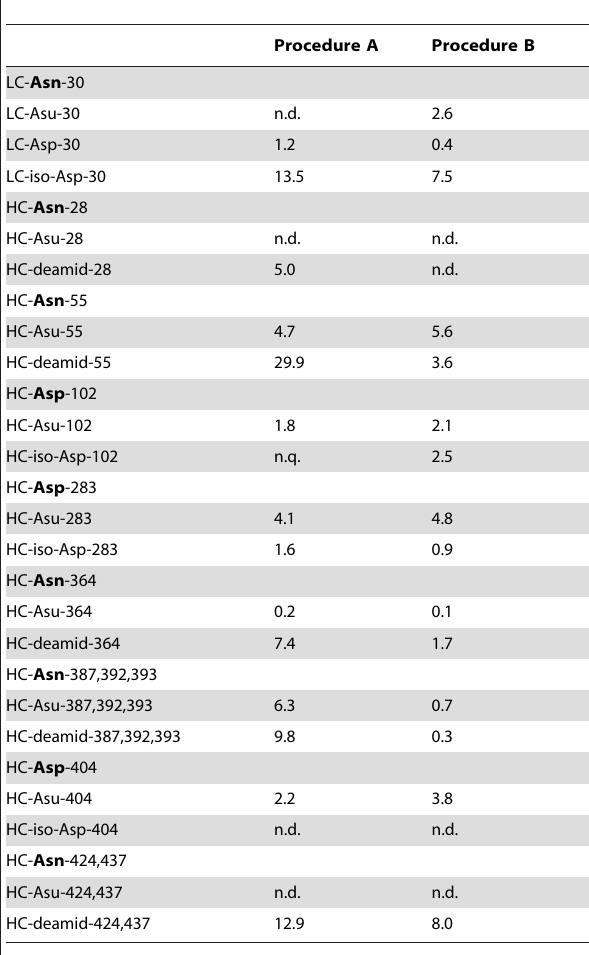
Table 1. Comparison of the pH 7.0 (procedure A) and pH 6.0 (procedure B) sample preparation procedures for the UPLC- MS analysis of HER2 Asn deamidation and Asp